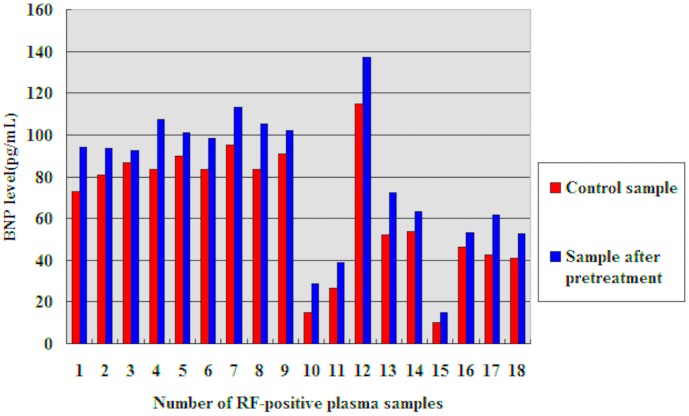
A comparison of the BNP levels measured in RF-positive plasma pretreated with or without IgG-sensitive latex particles.